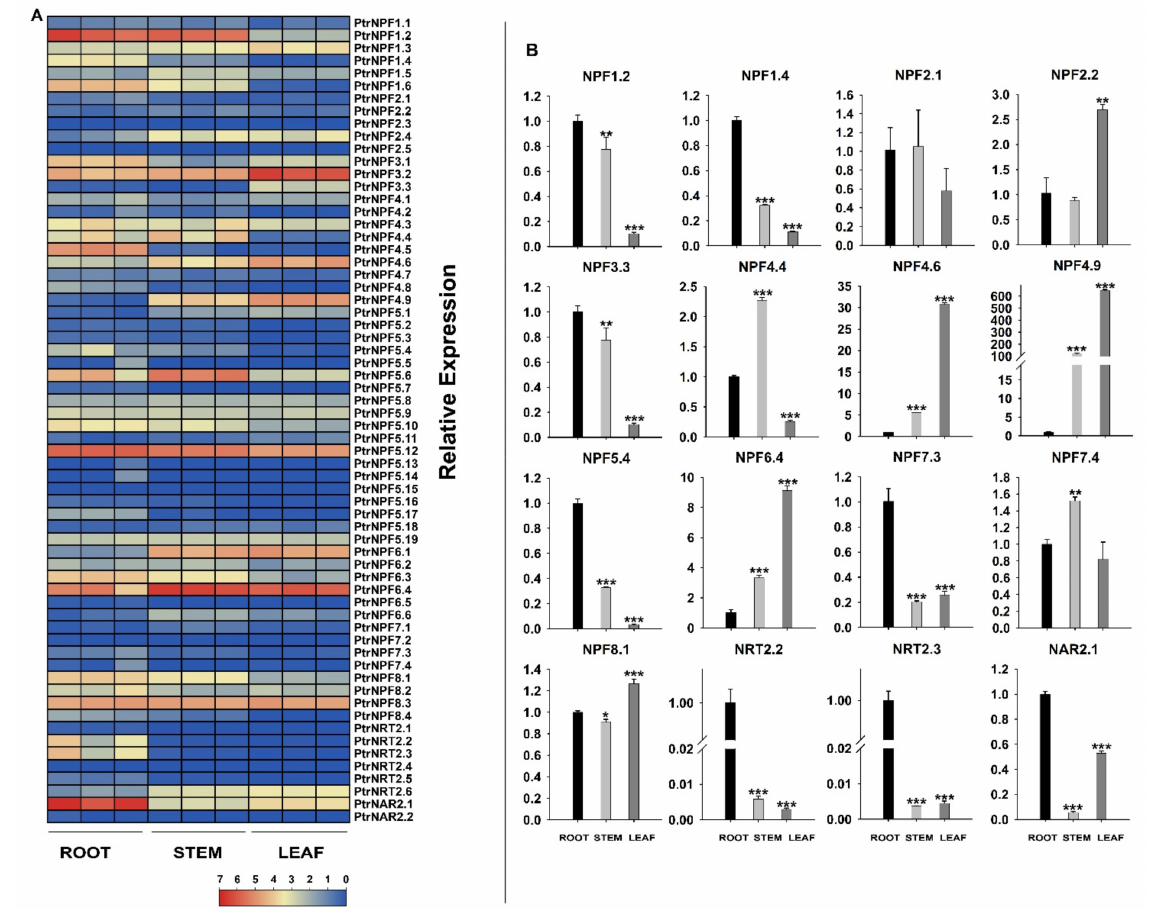
Figure 4. Differential gene expression of PtrNRTs in a variety of tissue. ( A ) The FPKM value of 64 PtrNRT genes in a heatmap. ( B ) The relative expression of selected PtrNRT members by qRT- PCR assay. The root tissue was defined to be the reference. * Represented significant differences in comparison with root group using Student’s t -test at 0.01 < p < 0.05. ** Represented significant differences at 0.001 < p < 0.01. *** Represented significant differences at p <